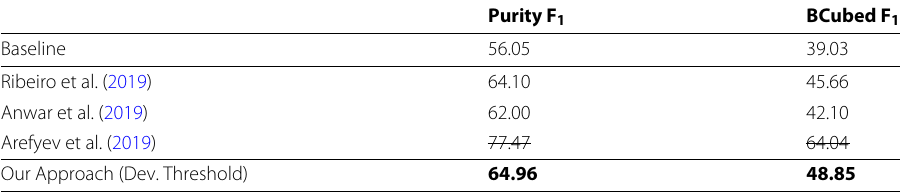
Table 12 Comparison of semantic role induction results with those of previous approaches in terms of performance on the test